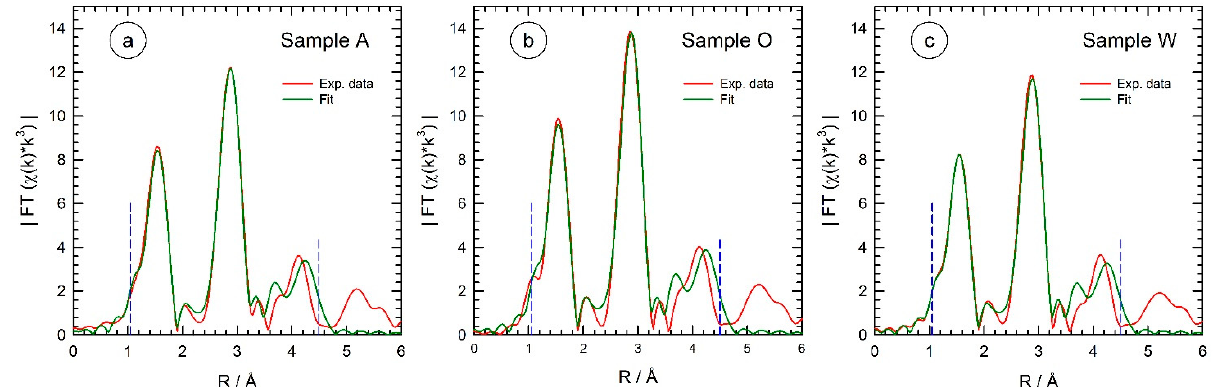
Figure 5. Fits of the EXAFS data measured after extraction of the prepared ZnO nanomaterials from the reaction cell after finalization of the reaction. The data were fitted to a model structure consisting of hexagonal, wurtzite-type ZnO (k-range for the fits: 1.2 Å − 1 < k < 12.4 Å − 1 , Kaiser-Bessel-window functions, R-range 1.0 Å < R < 4.3 Å, dashed vertical blue lines). ( a ) The reaction of Zn(acac) 2 solution in 10 − 3 M NaOH (sample A); ( b ) reaction of Zn(acac) 2 solution in 1-octanol (sample O); and ( c ) reaction of Zn(acac) 2 solution in distilled water (sample W).